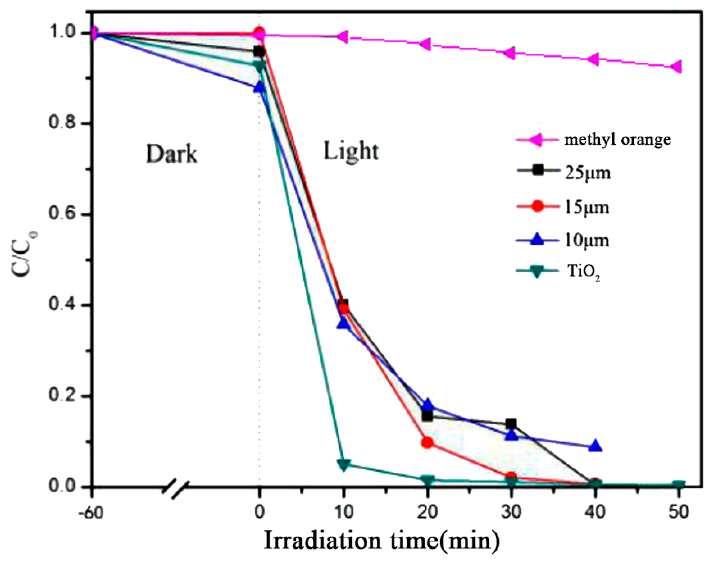
Figure 1. Effect of the particle size of CaCO 3 on the performance of the composite